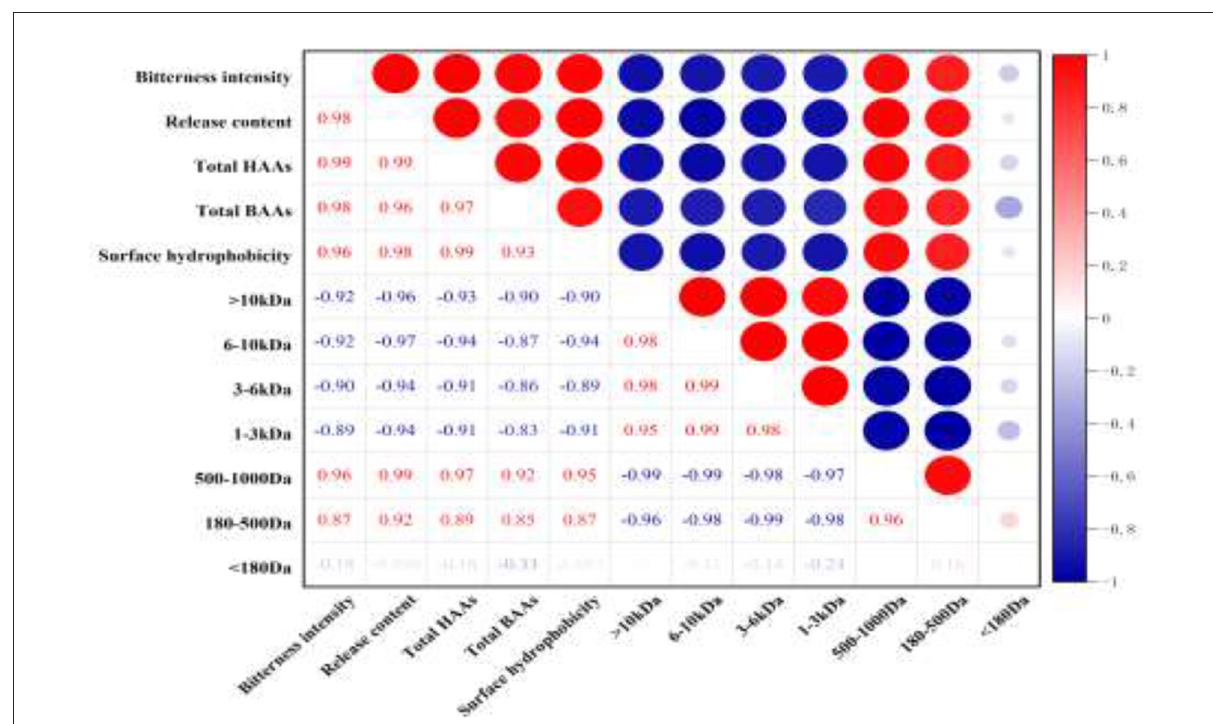
FIGURE5 Heat map of correlation coefficient between different indicators (red represents positive correlation, blue represents negative correlation, and the depth of color reflects the size of correlation